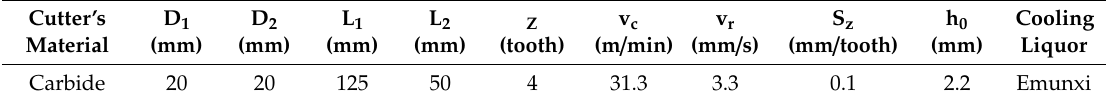
Table 4. The cutter parameters and the milling process parameters.